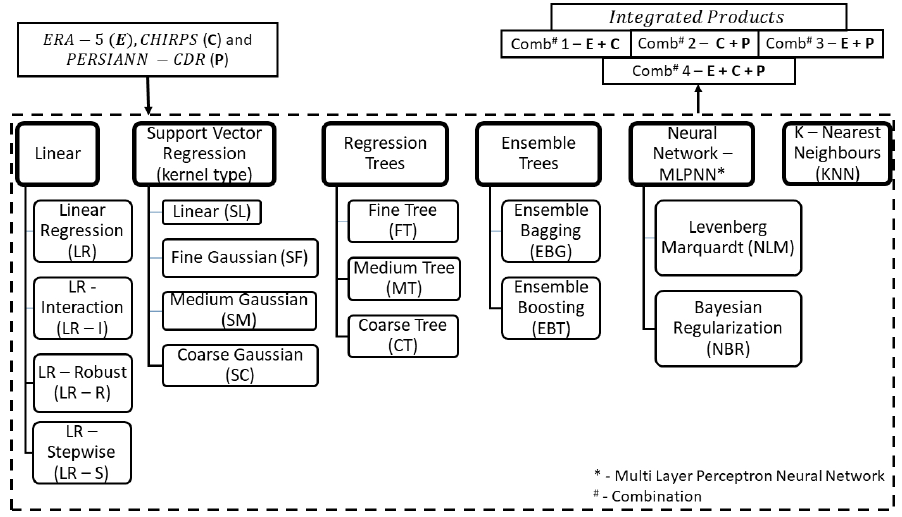
Figure 2. Methodology implemented in the study. Table 1. Hyperparameter values for all the 16 machine learning algorithms used in the study.